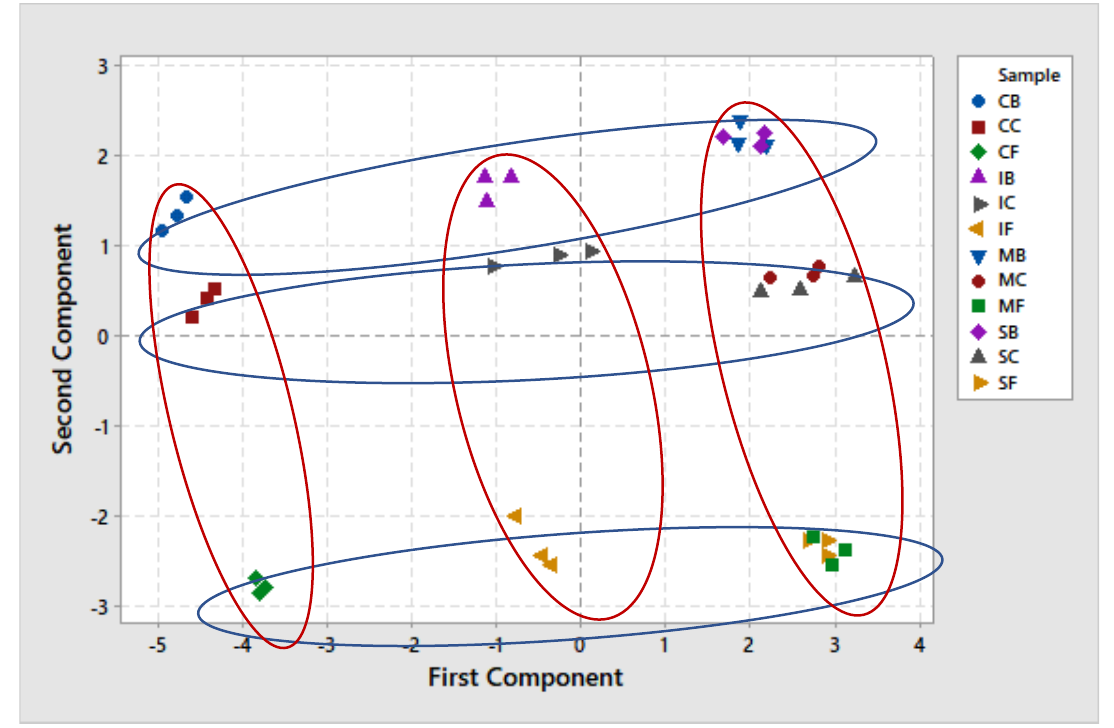
Figure 6. PCA score plot of the considered chestnut groups. Average values ( n = 3) were included for all the samples. Chestnut group IDs were reported in Table 1. all the samples. Chestnut group IDs were reported in Table